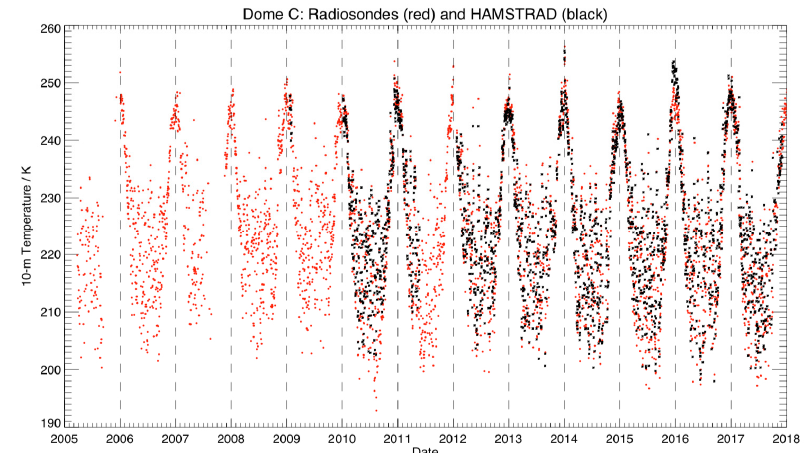
Figure 2. Time evolution of daily-averaged 10-m temperature (K) measured at Dome C from 2005 to 2017 by the radiosondes (red filled circles) and from 2009 to 2017 by HAMSTRAD (black stars). Over the periods considered, the annual cycle indicates a dry (~0.1 kg m − 2 ) and cold (~205 K)